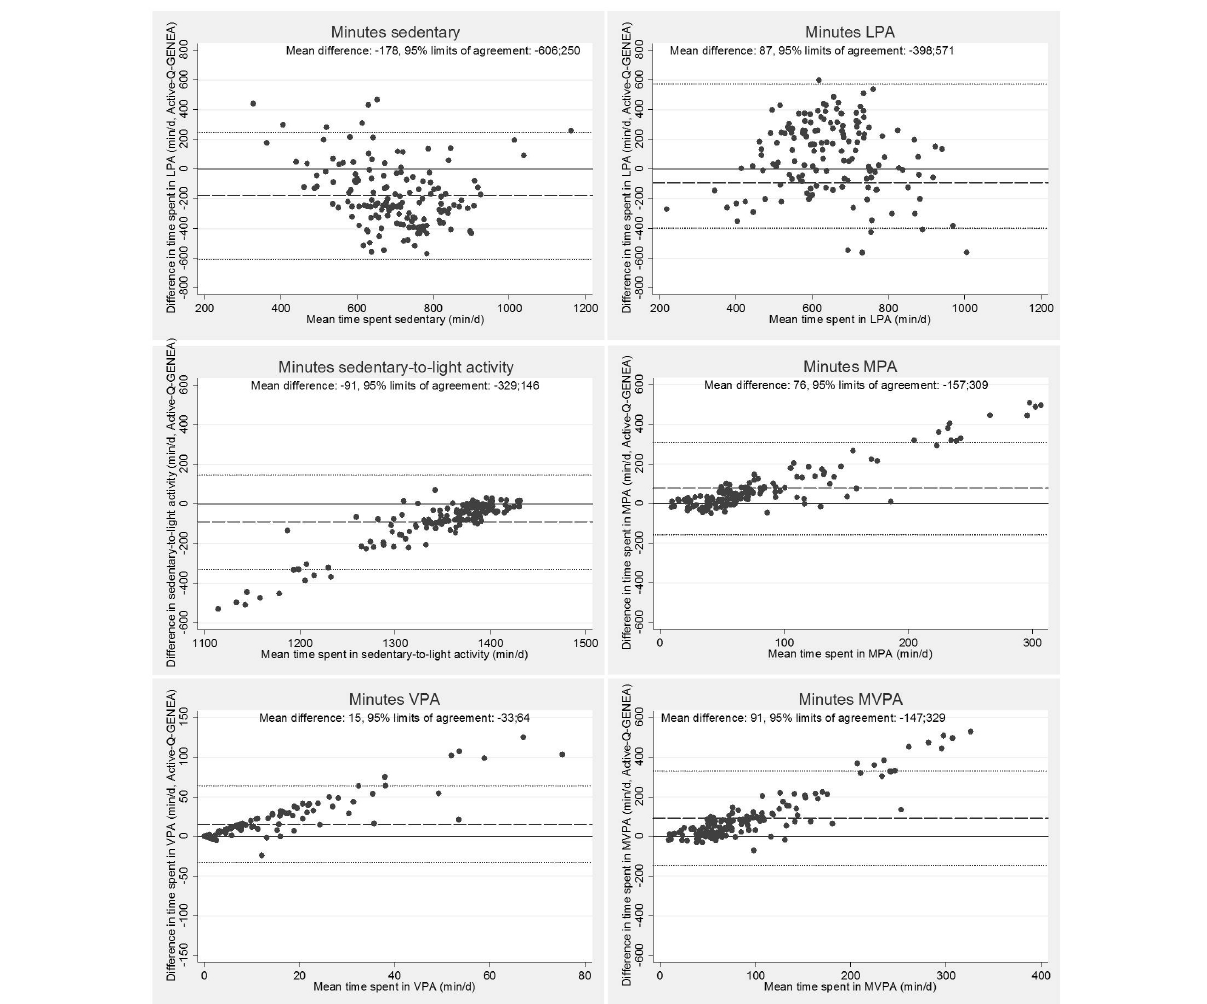
Figure 4. Bland-Altman plots illustrating differences in time spent sedentary, in light (LPA), sedentary-to-light, moderate (MPA), vigorous (VPA), and moderate-to-vigorous (MVPA) physical activity assessed with Active-Q and GENEA (y-axis) relative to the mean of the two methods (x-axis). Each point represents one study participant